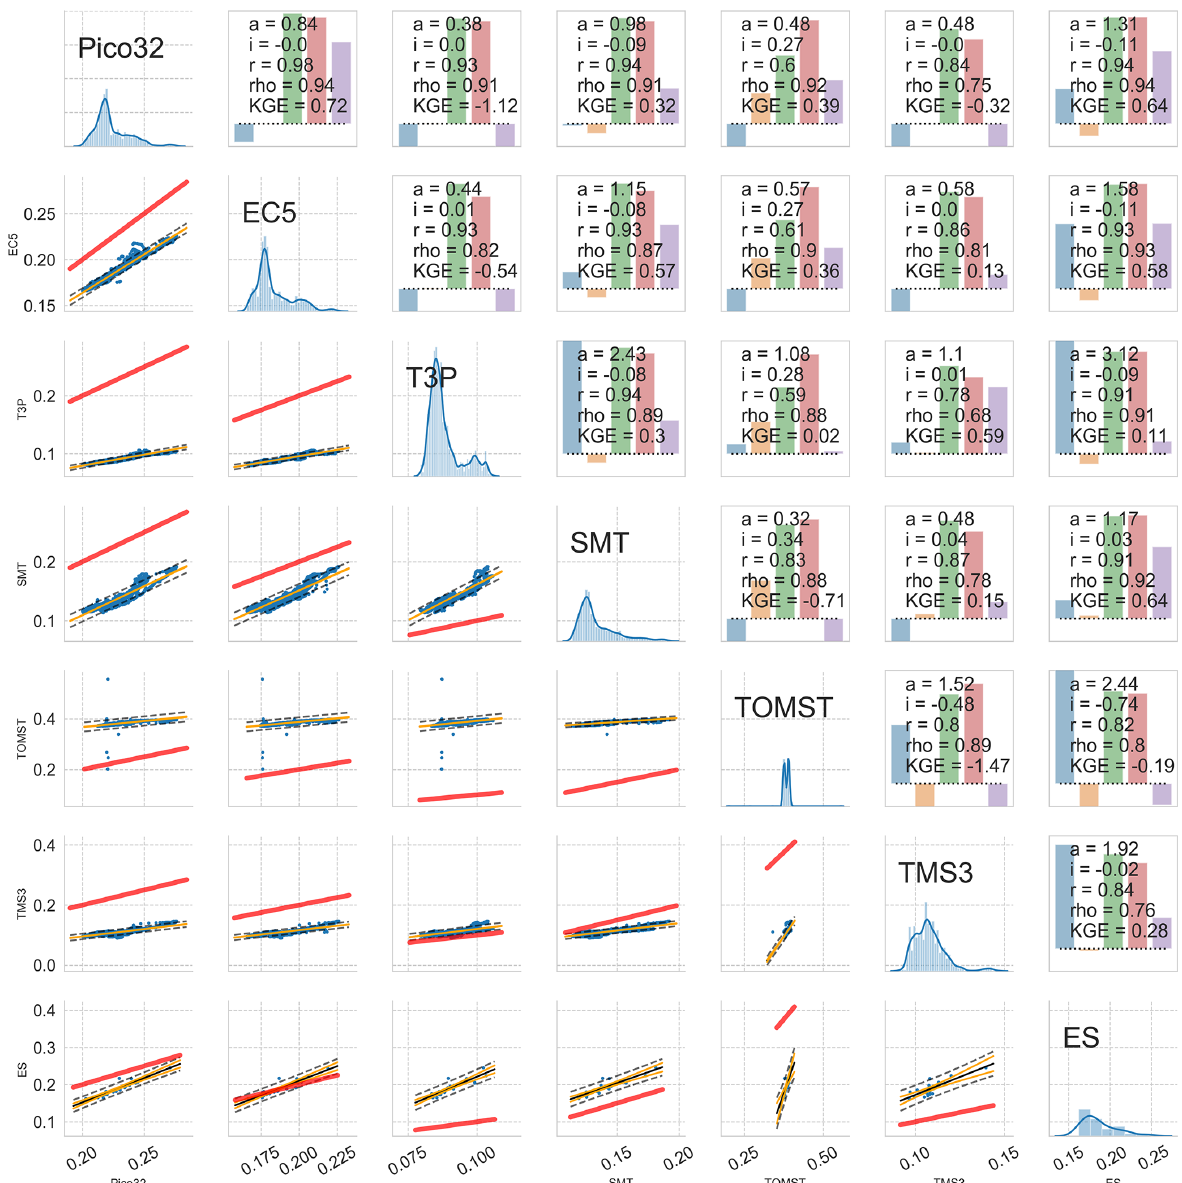
Figure A1. Correlation matrix of two references and the less plausible soil moisture sensor systems (values given in m 3 m − 3 ). Diagonal panels give histogram and kernel density distribution of 0.5h means of all sensors of one system. Lower half gives scatter plot (blue dots), linear regression (orange line), 0.95 predictive uncertainty bands (grey dashed lines) and the 1 : 1 line (red). The upper half reports the respective correlation measures, with a and i as scaling factor and intercept of the linear regression model, r as Pearson correlation coefficient, rho as Spearman rank correlation coefficient, and KGE as Kling–Gupta efficiency. These values are plotted as bars in the same order in the background, where a is plotted as deviation from unity. The ES system did not record data in the desired density (only 27 values compared, which is 0.5% of the data